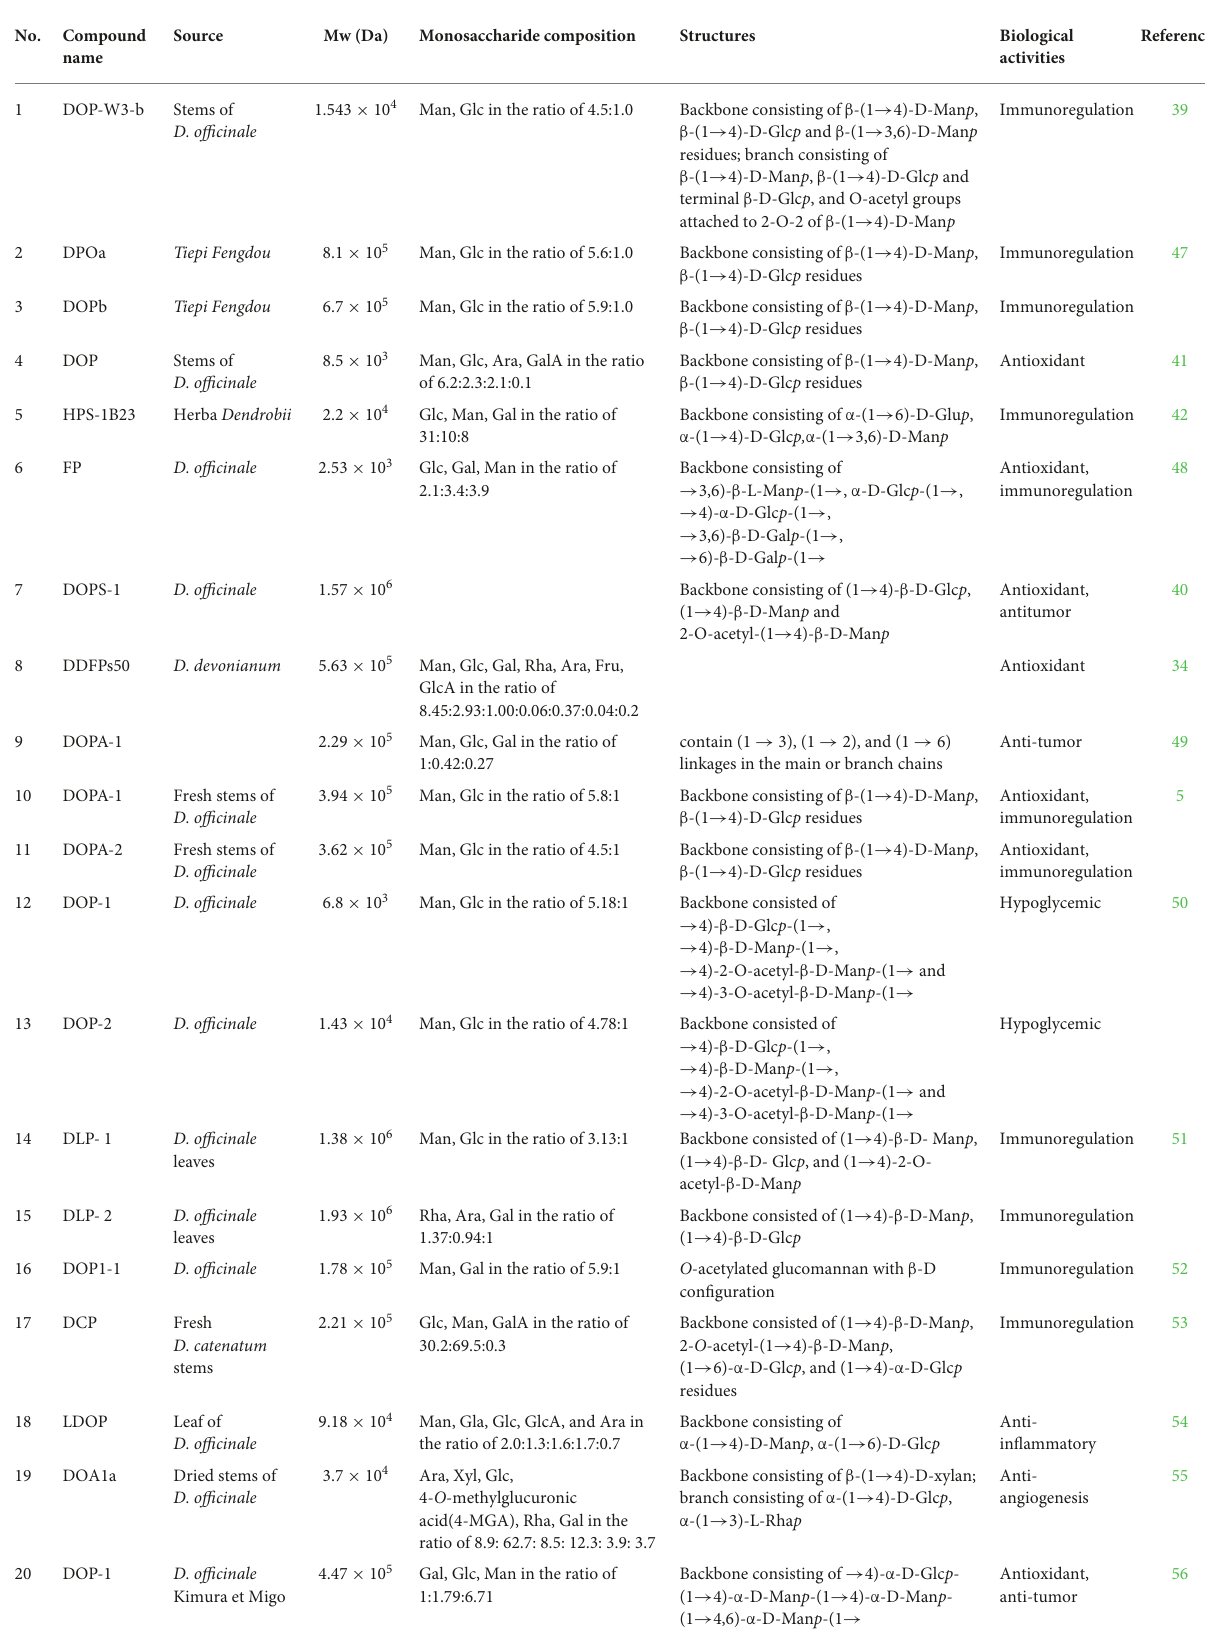
TABLE 1 The polysaccharides isolated from Dendrobium officinale